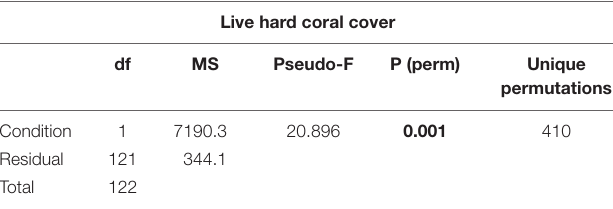
TABLE 3 | Results of one-way PERMANOVA on live hard coral cover in shallow reefs (5 m depth) between lagoon reefs and ocean reefs after the bleaching event of